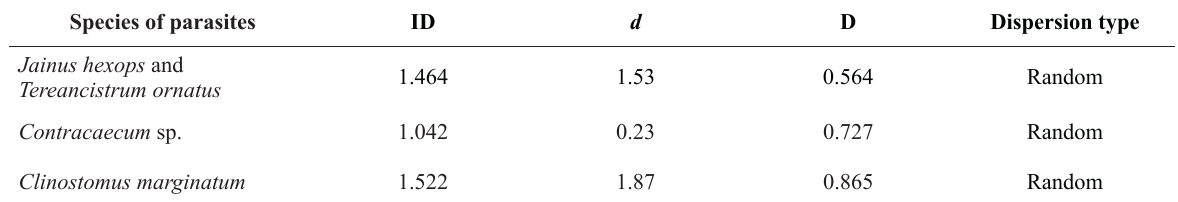
Dispersion index (ID), statistic- d and discrepancy index (D) for the parasites infracommunities of metazoan parasites of Hemibrycon surinamensis from the Matapi River, in Amapá State, Brazil.